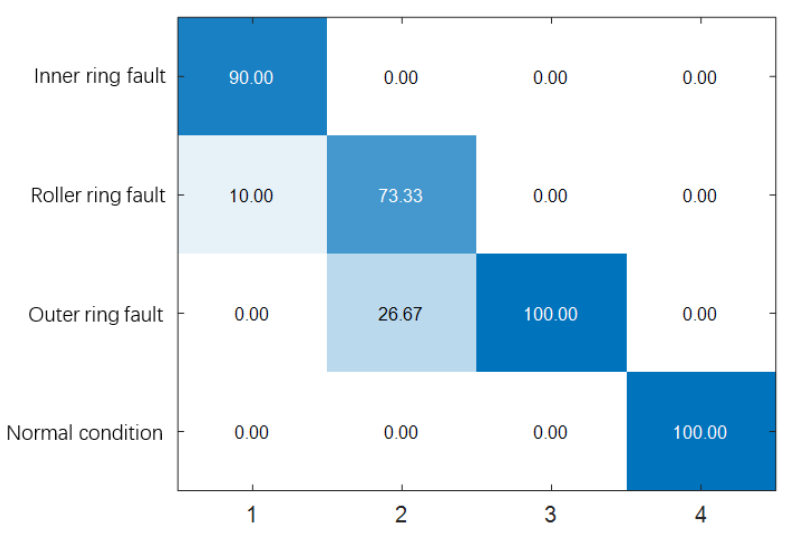
Figure 9. VMD-CMDE-DBN fault recognition rate .